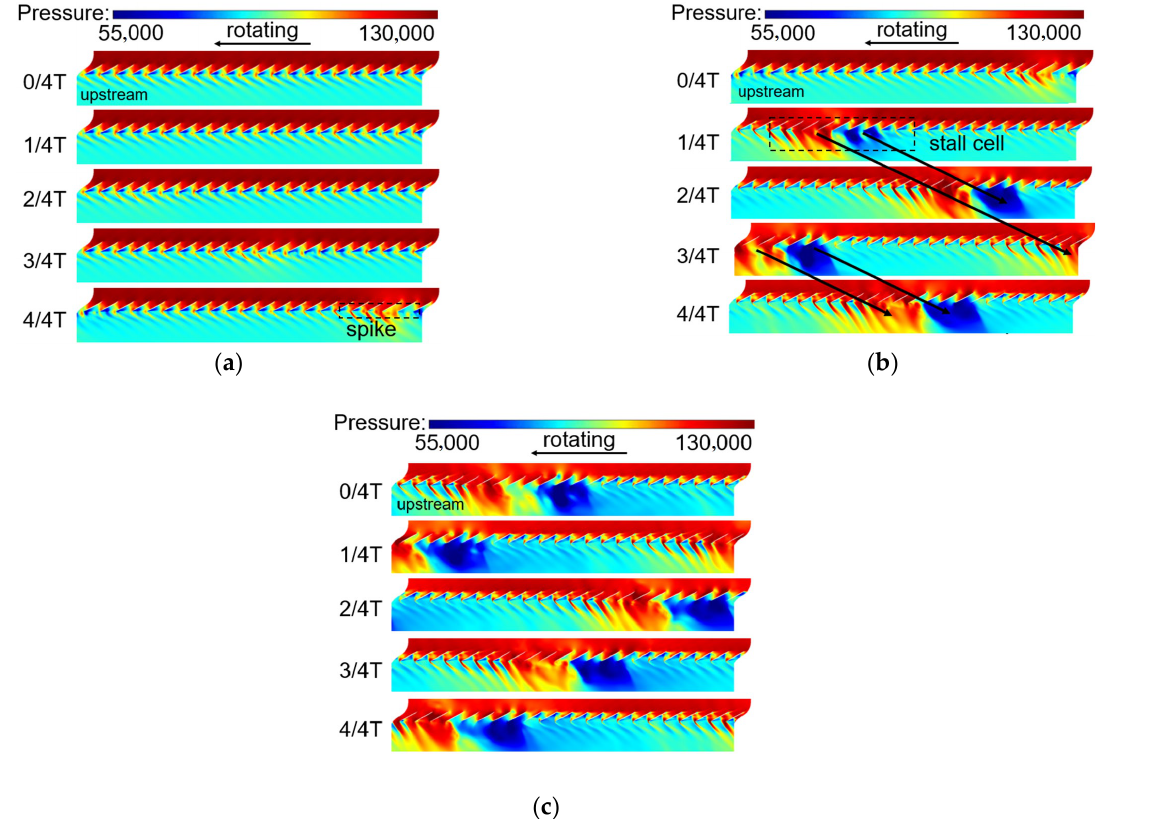
Figure 8. Original flow field. ( a ) Pre-stall flow field. ( b ) During-Stall flow field. ( c ) Stable-stall flow field.